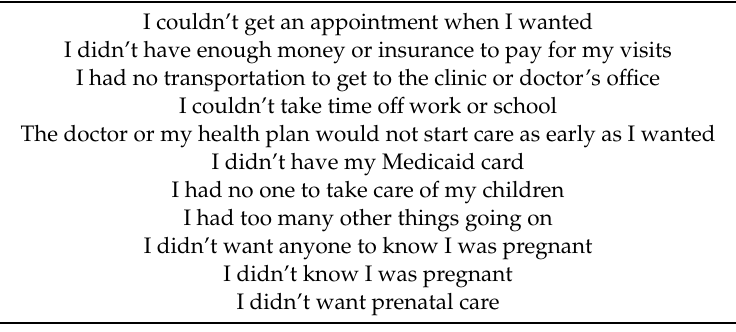
Table A2. Individual Barriers to Prenatal Care. Table B. Individual Barriers to Prenatal Care.